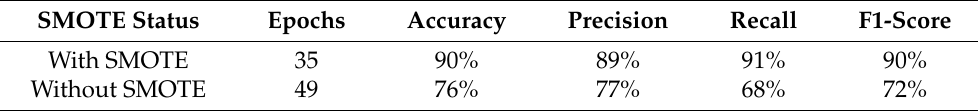
Table 6. Comparison SMOTE